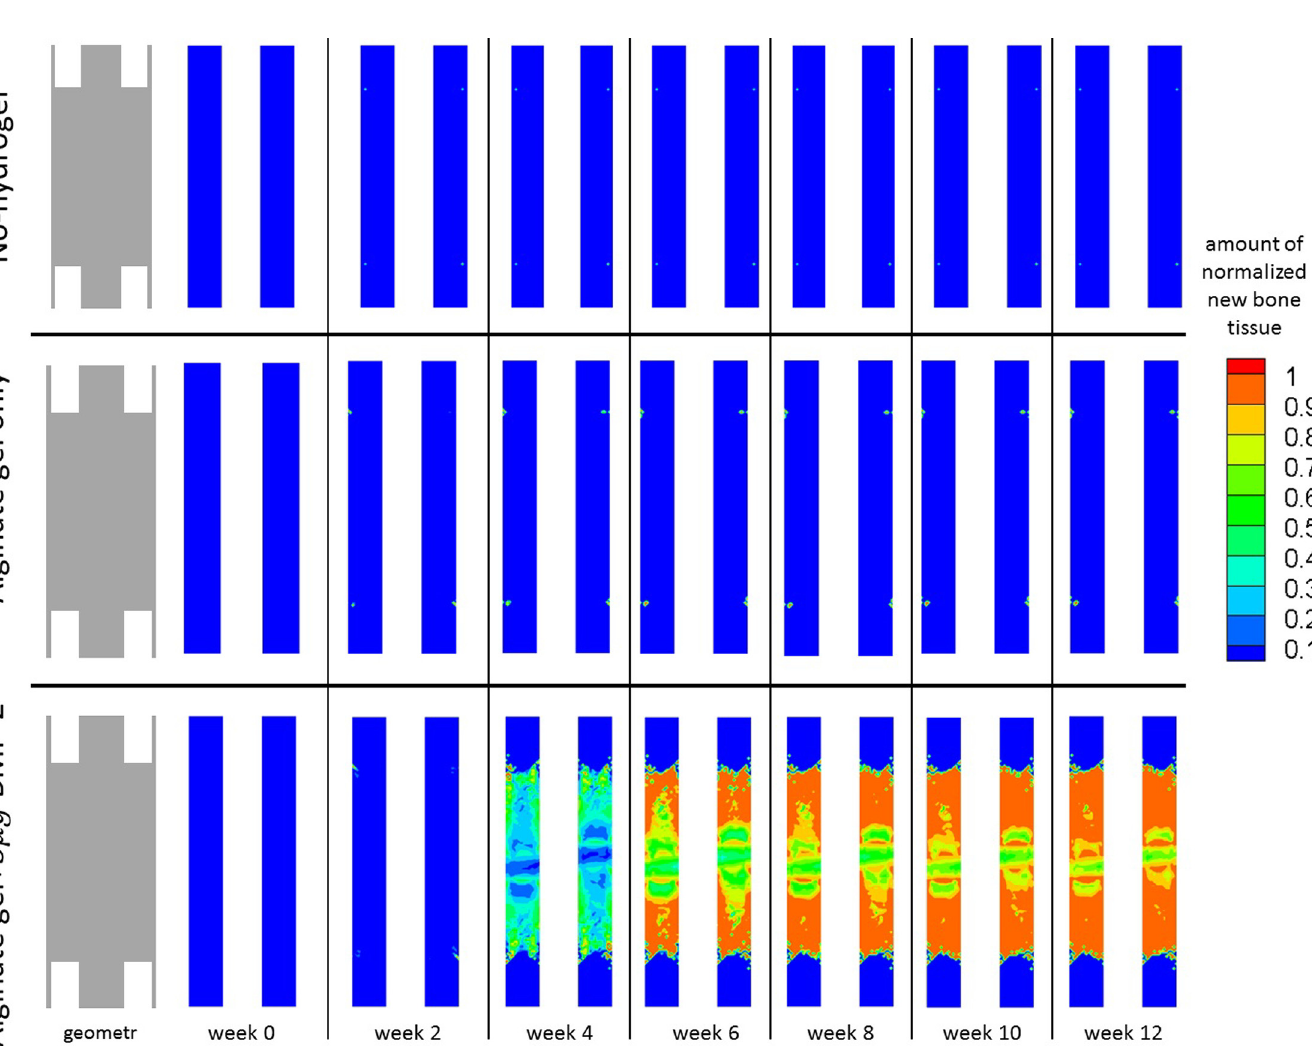
Fig 8. Evolution of new bone tissue. Evolution of the normalized amount of new bone tissue inside the bone defect over 12 weeks, when: no hydrogel was placed inside the bone defect (top); an alginate hydrogel was placed inside the bone defect (middle), and an alginate hydrogel with 5 μ g of BMP-2 (bottom) was placed inside the bone